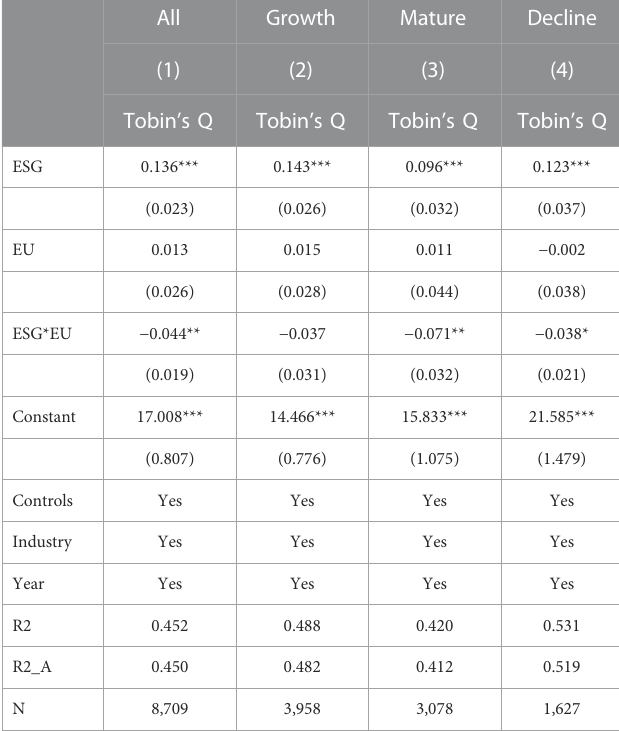
TABLE 17 The moderate effect of environmental